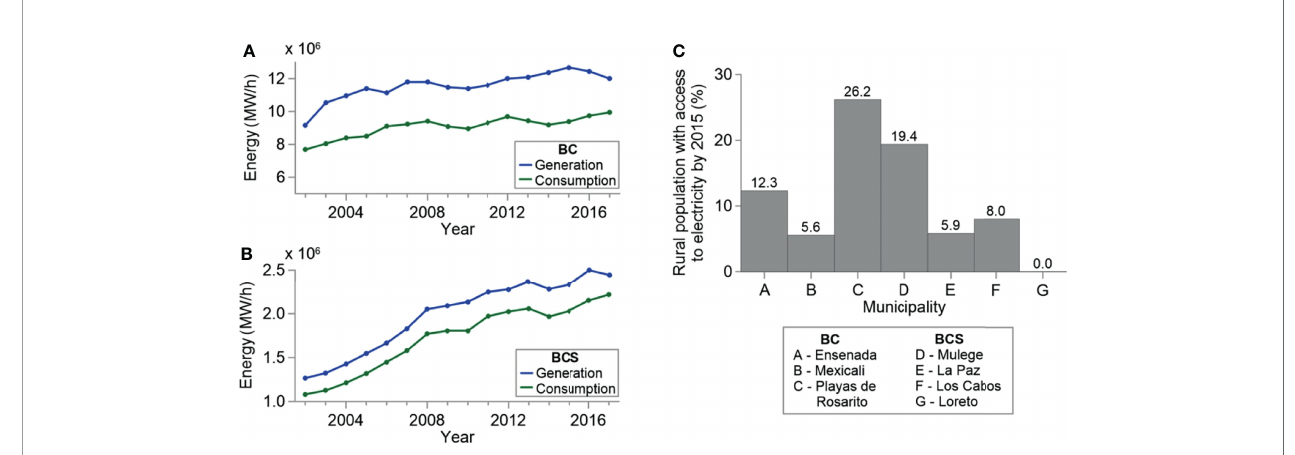
FIGURE 2 | Energy generated and consumed in (A) Baja California (BC) and (B) Baja California Sur (BCS) from 2002 - 2017. (C) Rural population with access to electricity in BC